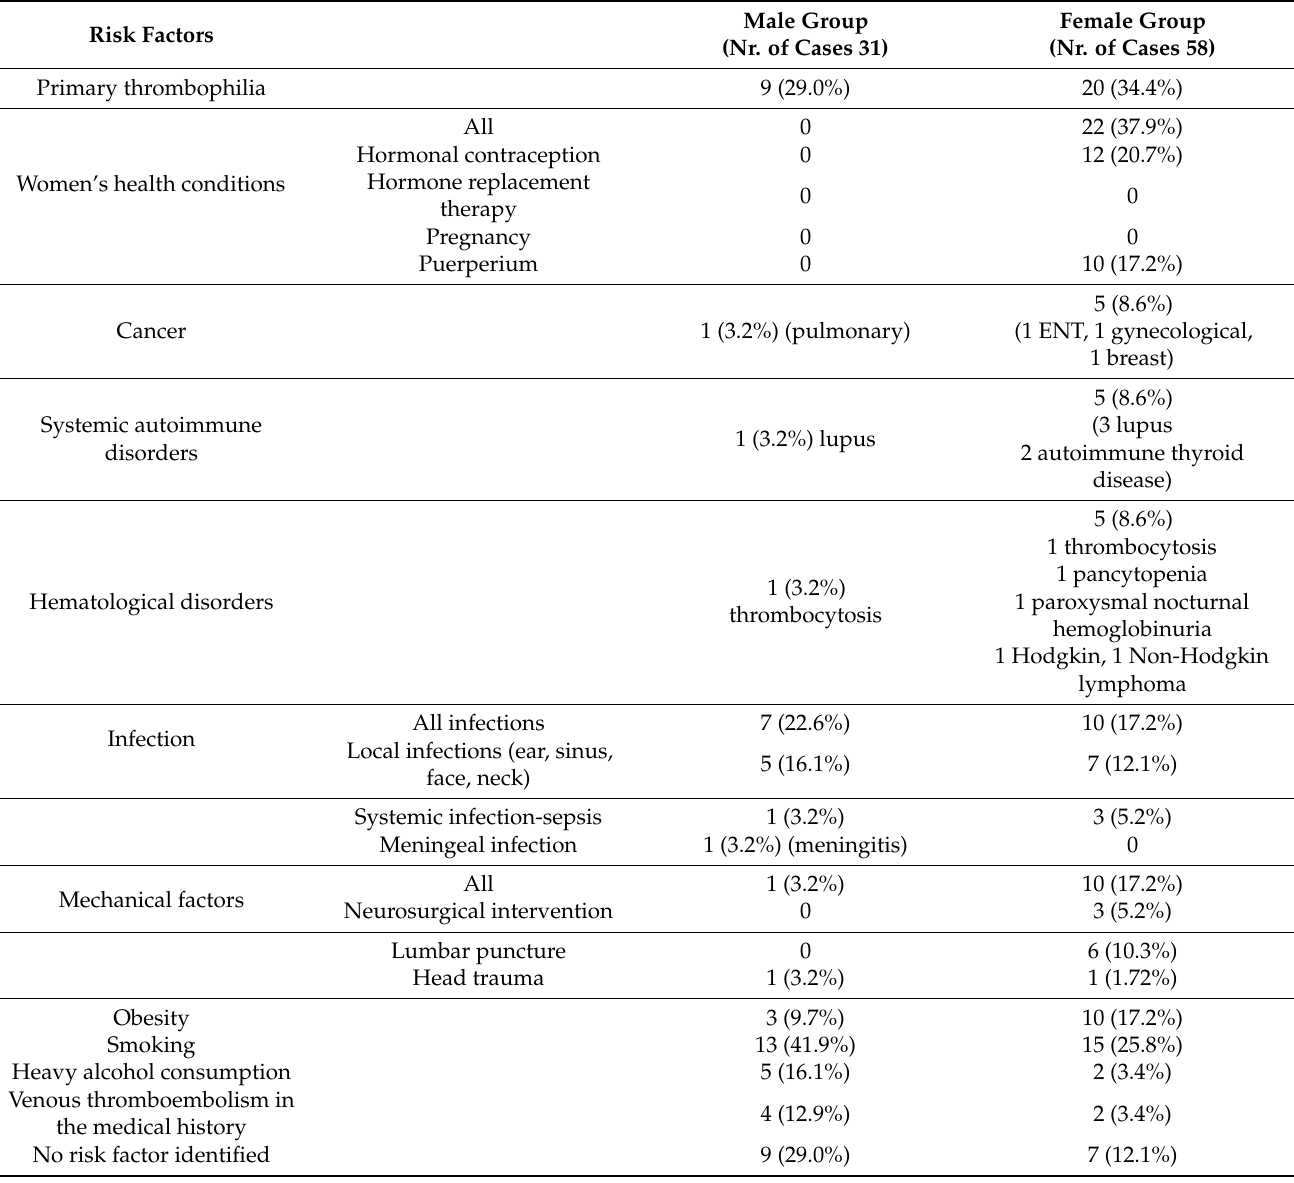
Table 1. Risk factor profile in male and female